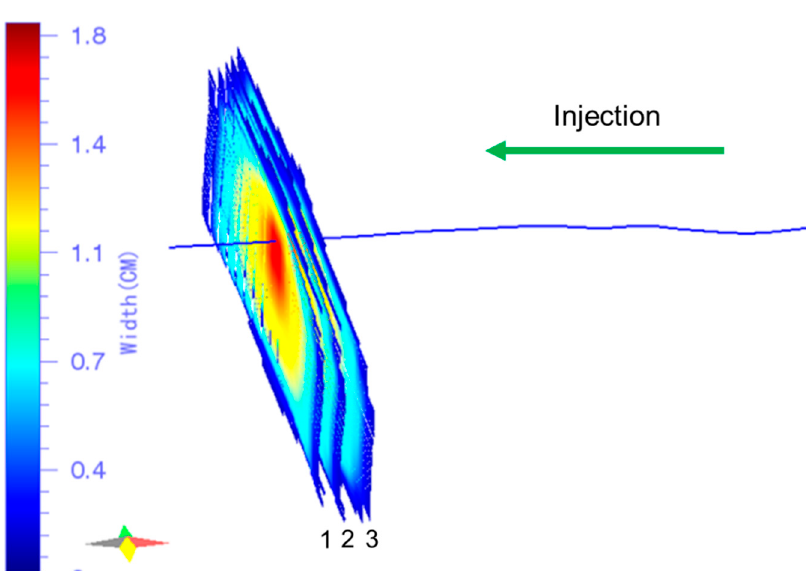
Figure 18. 3D view of the three fractures.